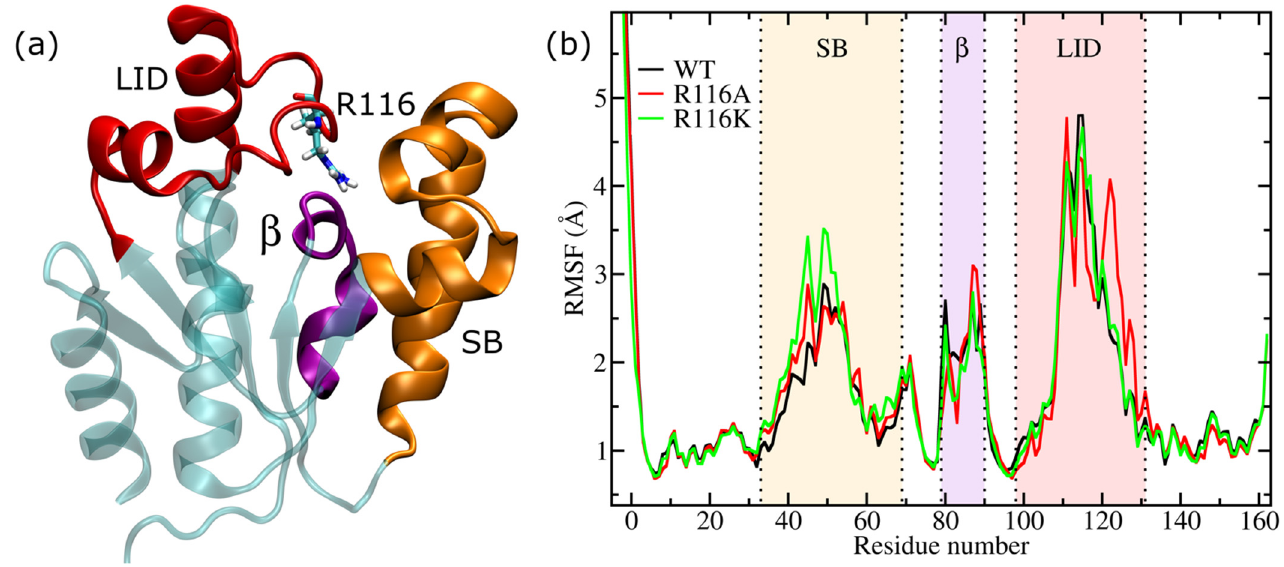
Figure 2. RMSFs results for the WT and the mutants R116: ( a ) regions with the largest fluctuations, i.e., the LID region (in red), the SB region (in orange), and the 3 10 helix which is part of the β region in the CORE domain (in purple); ( b ) RMSF values for the three variants and the most affected regions marked with similar colours as in ( a ) for the regions.